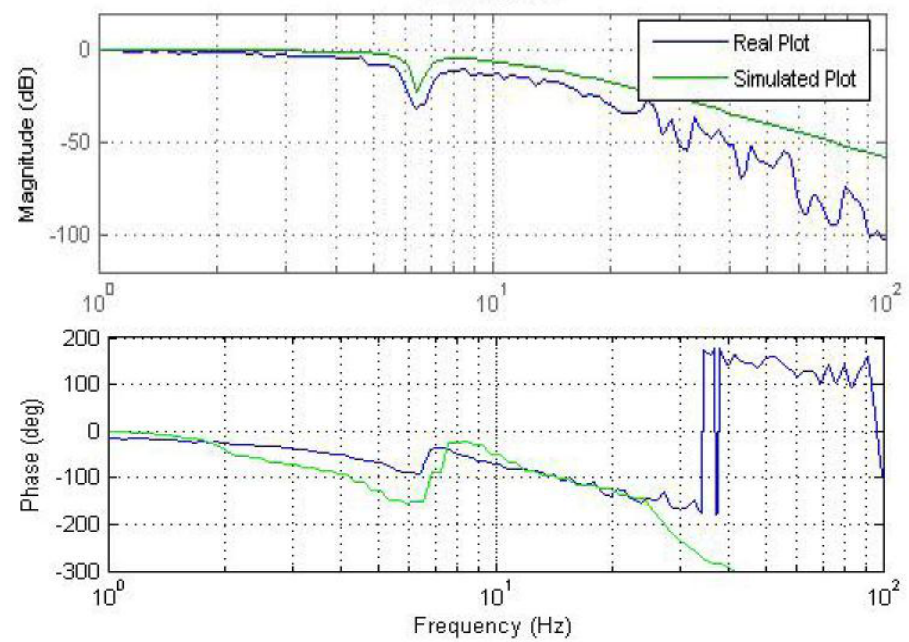
Figure 11. Bode plot for good valve